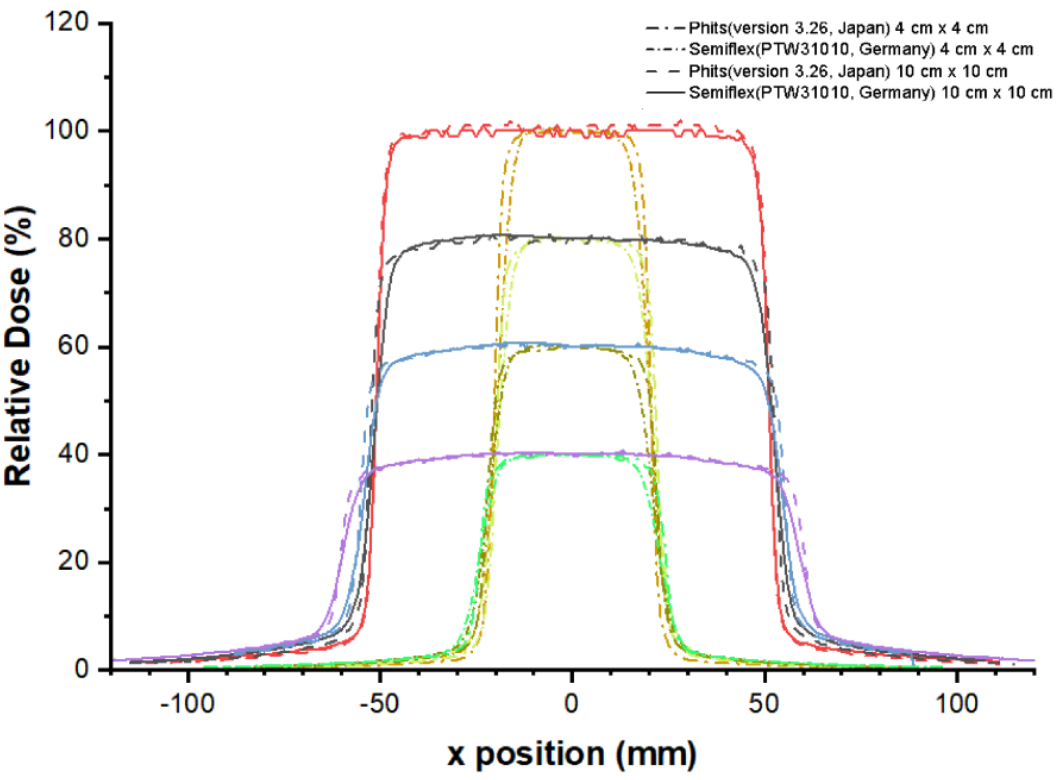
Figure 4. Superimposed beam profiles of measured and simulated values for Varian Clinac 6MV: the in-plane was evaluated by dividing by field size of 5 mm, 50 mm, 100 mm, and 200 mm depths (4 cm × 4 cm, 10 cm × 10 cm).